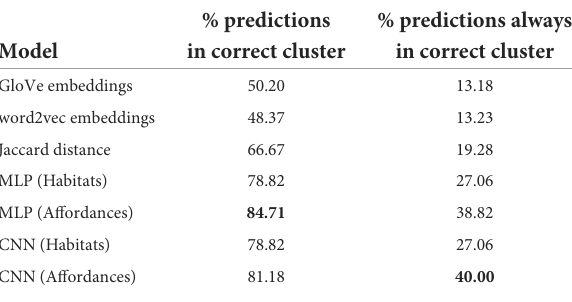
TABLE 1 MLP (L) and CNN (R) architectures. TABLE 2 Prediction accuracy results with 6